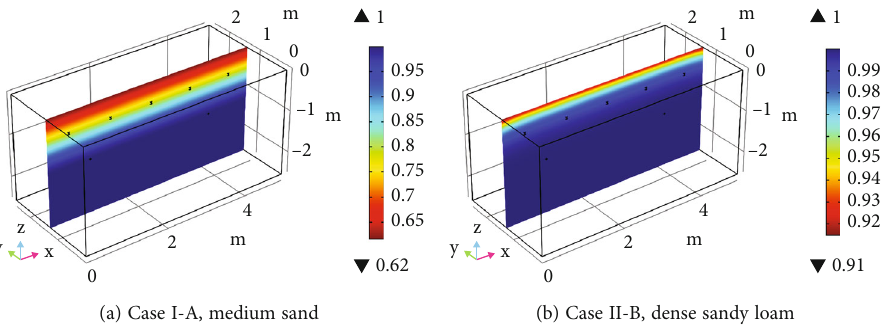
Figure 9: Normalized water content after 150 mins of drying